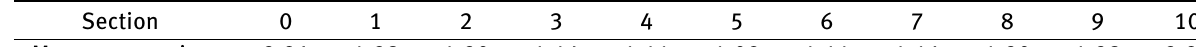
Table 1: Porta Napoli arch: Maximum compressive stresses following Mery’s Method.